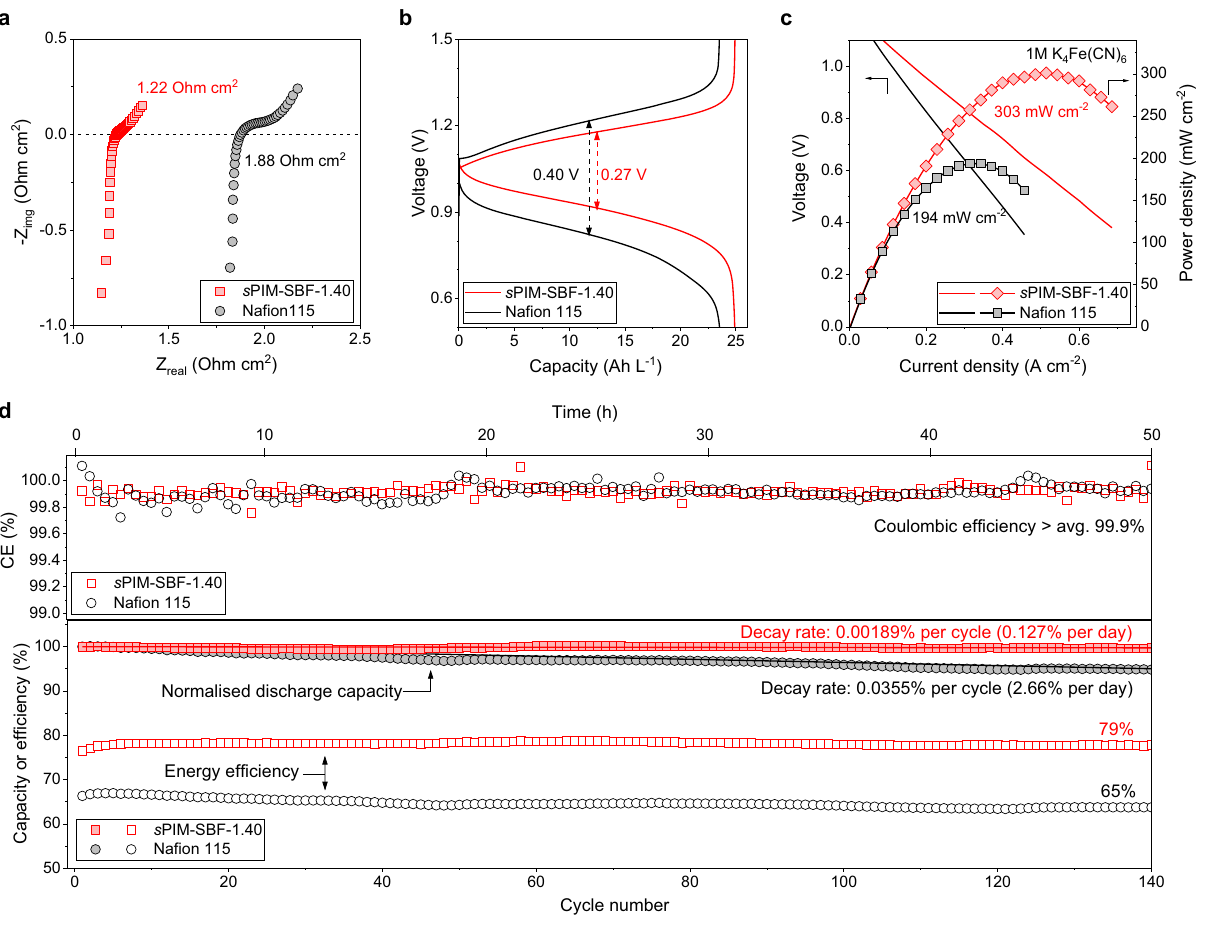
Fig. 5 High-concentration redox fl ow battery performance. a EIS spectra of K 4 Fe(CN) 6 (1 M)|2,6-DPPAQ (0.4 M) fl ow battery cells at 100% SOC. b Capacity-voltage pro fi le of the 2nd charging-discharging cycle at a current density of 100 mA cm − 2 . c Voltage and power density versus current density at ~100% SOC using s PIM-SBF-1.40 and Na fi on 115 membrane. d Cycling stability of RFBs using K 4 Fe(CN) 6 (1 M)|2,6-DPPAQ (0.4 M) assembled with s PIM-SBF-1.40 or Na fi on 115 membranes at pH = 9 and a current density of 100 mA cm − 2 . Solid symbols represent normalized discharge capacity and open symbols represent energy ef fi ciency. Normalized discharge capacity data are linearly fi tted to derive capacity decay rates. The operating temperature in the glovebox is around 30 tetra fl uoroterephthalonitrile (2.63 g, 13.14 mmol) were dissolved in anhydrous Supplementary Fig. 2. Detailed synthetic procedure of s PIM-SBF-1.40 was DMF (66 mL) at around 25 °C under a nitrogen atmosphere. Anhydrous K 2 CO 3 described below as an example. TMSCS (2.09 mL, 13.60 mmol, 1.7 equiv.) in (14.53 g, 105.15 mmol) was added and the mixture was heated at 65 °C for 92 h. On anhydrous chloroform (5 mL) was added dropwise to a solution of PIM-SBF (4.0 g, cooling, the mixture was poured into water (500mL), acidi fi ed with hydrochloric 8.00 mmol, 1 equiv.) in anhydrous chloroform (135mL) at 50°C under a nitrogen acid (2M) and fi ltered off. The precipitate was washed repeatedly with water, atmosphere. The yellow reaction solution turned brown upon the addition of acetone, and methanol, reprecipitated twice from the mixture of acetone/methanol TMSCS, and was stirred at 50 °C for 24h. On cooling, the brown reaction mixture (2/1, v/v, 700 mL) to remove oligomers, and subsequently re fl uxed in methanol was added to methanol and collected by fi ltration. The obtained solid was soaked in overnight to remove traces of residual solvent. The resulting product was collected ammonium hydroxide (200mL, 28% NH 3 in H 2 O) at around 25°C for 12 h to by fi ltration and dried under vacuum at 110°C for 12 h to afford the fi nal polymer cleave the trimethylsilyl (TMS) groups. Subsequently, the solids were fi ltered off, as yellow powder (5.59 g, 85%). v max (cm − 1 ): 3060, 2896, 2239, 1601, 1435, 1350, stirred 3 times for 2h with aqueous KCl solution (200mL, 1M), washed thor- oughly with deionized water and fi nally dried under vacuum at 110 °C overnight to 1269, 1200, 1153, 1103, 1011, 868, 740; 1 H NMR (500MHz, CDCl 3 ): δ (ppm) 7.71 yield s PIM-SBF-0.98 in potassium ion form as an orange powder (4.68 g, 95%). (br s, 2H, ArH), 7.41 (m, 4H, ArH), 7.13 (br s, 2H, ArH), 6.70 (br s, 2H, ArH), 6.38 s PIM-SBF polymers with fi ve different degrees of sulfonation were prepared by (m, 2H, ArH); 13 C NMR (126 MHz, CDCl 3 ): δ (ppm) 147.8, 145.2, 139.2, 124.0, adjusting the molar ratio of TMSCS and PIM-SBF repeating units to 5.0, 3.0, 1.7, 120.4, 112.7, 109.0, 108.4, 94.4, 65.4. 1.0, 0.5, and designated as s PIM-SBF-1.86, s PIM-SBF-1.67, s PIM-SBF-1.40, s PIM- SBF-0.98, s PIM-SBF-0.53 based on IEC, respectively. Since s PIM-SBF polymers Synthesis of sulfonated model compound ( s SBF-OMe) . A solution of TMSCS with varied degree of sulfonation show same characteristic peaks in FT-IR and 13 C (230mM) in CDCl 3 (100µL) was added to a solution of 2,2 ′ ,3,3 ′ -tetramethoxy-9,9 ’ - NMR spectra, the FT-IR and 13 C NMR characteristic peaks of s PIM-SBF-1.40 were spirobi fl uorene (SBF-OMe, 46 mM) in CDCl 3 (400µL) at 273K. The sample was listed below as an example. v max (cm − 1 ): 3400, 3060, 2239, 1601, 1435, 1350, 1269, then in situ monitored by 1 H NMR over a period of 12h at 278K. SBF-OMe: 1 H 1180, 1103, 1030, 1011, 868, 740, 663, 623; 13 C NMR (126MHz, CDCl 3 ): δ (ppm) NMR (600MHz,CDCl 3 ): δ (ppm) 7.71 (m, 2H, ArH), 7.34 (s, 2H, ArH), 7.32 (m, 148.3, 146.9, 138.6, 128.0, 125.7, 120.1, 111.5, 109.1, 93.0, 64.5. 2H, ArH), 7.03 (m, 2H, ArH), 6.66 (m, 2H, ArH), 6.23 (s, 2H, ArH), 4.03 (s, 6H, OCH 3 ), 3.64 (s, 6H, OCH 3 ); s SBF-OMe: 1 H NMR (600MHz,CDCl 3 ): δ (ppm) 7.89 Synthesis of 2,6-di(3-phosphenopropyloxy)anthraquinone (2,6-DPPAQ) . The (br m, 4H, ArH), 7.40 (br s, 2H, ArH), 7.10 (br m, 2H, ArH), 6.21 (br s, 2H, ArH), redox-active molecule 2,6-DPPAQ was synthesized following a reported method 51 . A mixture of 2,6-dihydroxyanthraquinone (7.80 g, 32.47 mmol), diethyl (3-bro- mopropyl)phosphonate (21.00 g, 81.06 mmol), anhydrous K 2 CO 3 (17.90 g, Synthesis of s PIM-SBFs . The sulfonation of PIM-SBF polymer was achieved using 129.51 mmol) and DMF (160mL) was heated to and kept at 100 °C for 12h. The mixture was cool down and DMF was removed. The solid was fi ltered off, washed trimethylsilyl chlorosulfonate (TMSCS) as the sulfonation agent as presented in